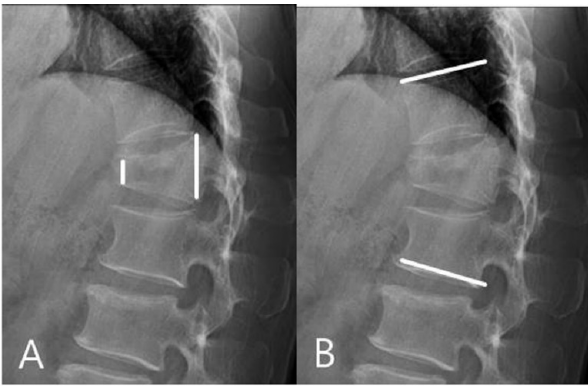
Figure 1. ( A ) Sagittal index (SI) was calculated by the ratio of the heights of the anterior and posterior vertebral wall. ( B ) Regional kyphosis angle (RKA) was measured on lateral radiographs using the Cobb method. RKA between the superior endplate of the vertebra above the fractured vertebra and the inferior endplate of the vertebra below the fractured vertebra were measured. RKA does not only stand for the deformity of the fractured vertebral body, but also the destruction of the affected intervertebral disc. Spinal canal encroachment and clearance were calculated before and after surgery on CT scans. The percentage of canal compromise was calculated with the narrowest mid-sagittal diameter of the injured level divided by the mean of the mid-sagittal diameters of adjacent upper and lower vertebra (Figure 2) [5,18].